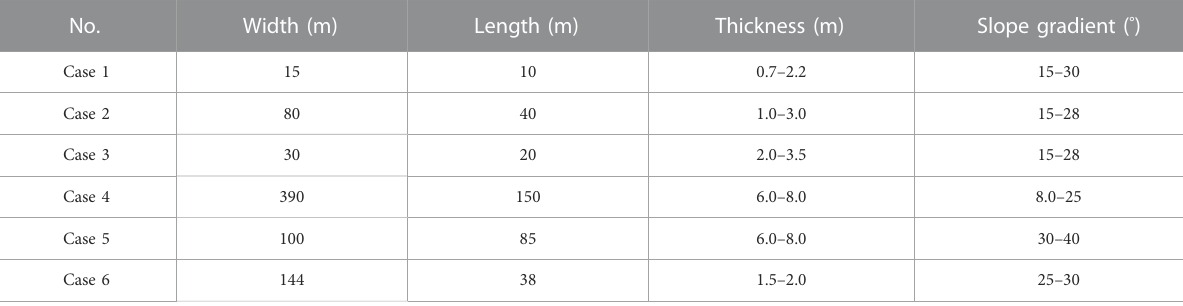
TABLE 1 Statistics of landslide parameters in typical pipeline landslide cases.